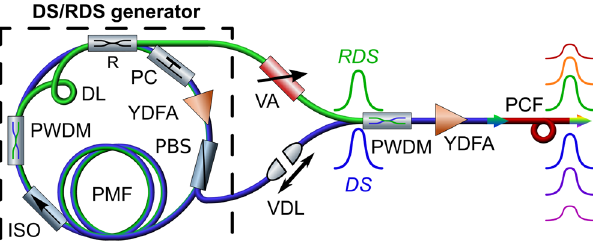
Figure 2. Experimental setup: The DS/RDS generator has two fiber outputs for the DS and RDS, which are combined by polarization wavelength division multiplexer (PWDM) after temporal and amplitude equalization by a variable delay line (VDL) and a variable attenuator (VA). After amplification by Yb-doped fiber (YDFA) they propagate together in the PCF thus generating their clones at new wavelengths both in short (anti-Stokes) and long (Stokes) wavelength domains. All components are PM, except for the intra-cavity YDFA with pigtails and the